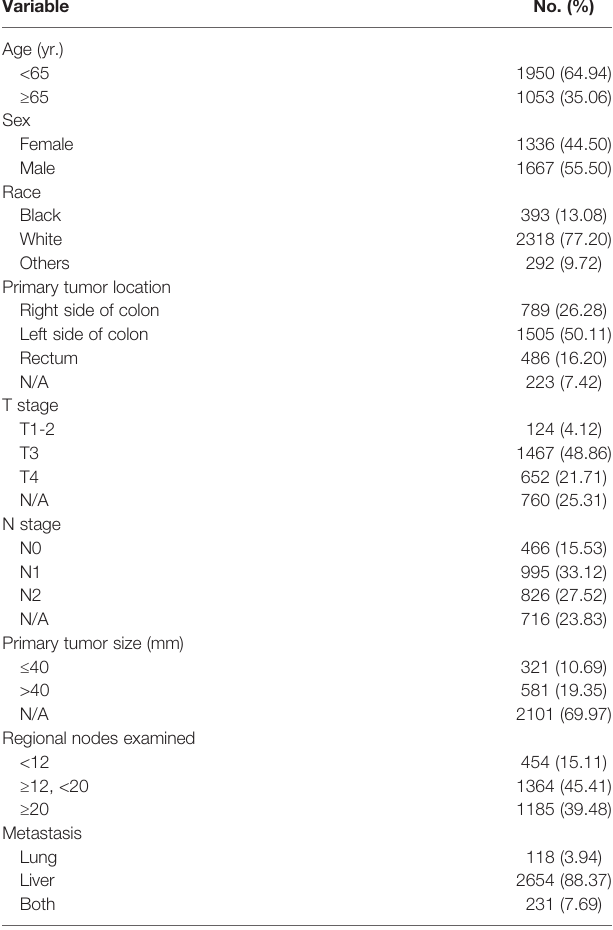
TABLE 1 | Characteristics of the